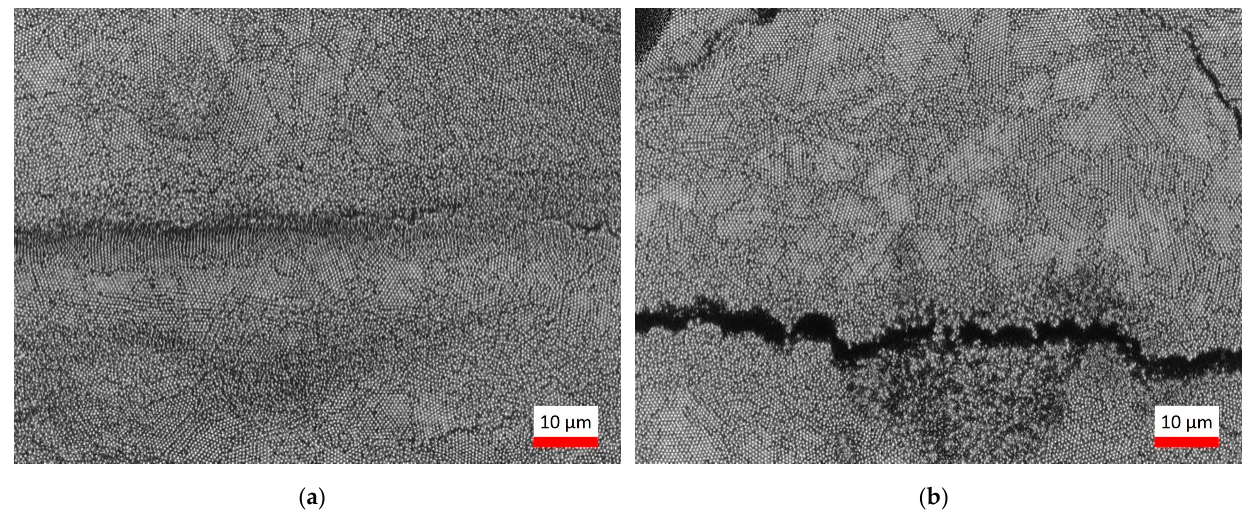
Figure 2. CLSM images of the PS sphere coated pine wood sample before ( a ) and after O 2 plasma treatment ( b ) with a magnification of 1500 × .